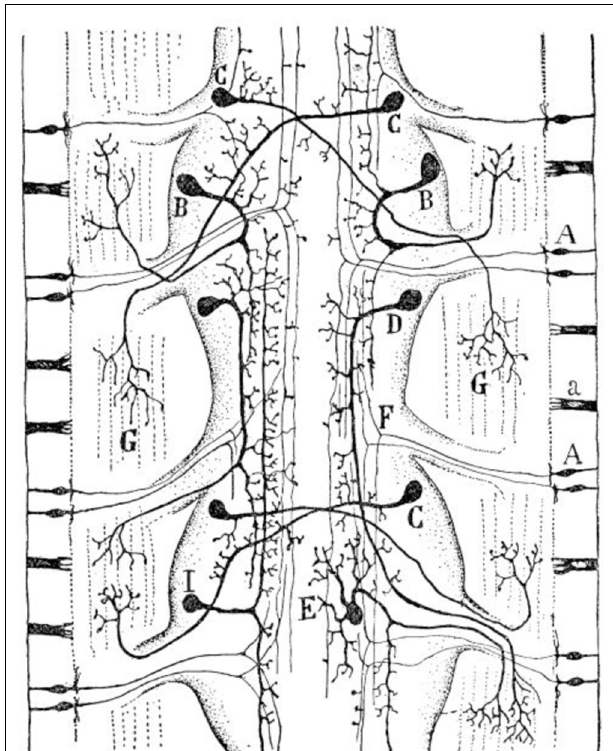
FIGURE 3 | Diagram of the sensory and motor nervous system of a worm (composite of two figures, one from Retzius and another by v. Lenhossék). (A) Sensory cells of the skin; (B) ipsilateral motor cells of central ganglia; (C) crossed motor cells; (D) ipsilateral longitudinal motor cells; (E) multipolar motor cell; (G) terminal ramifications of motor neurons in muscles; (I) interganglionar association cells.Taken from Cajal